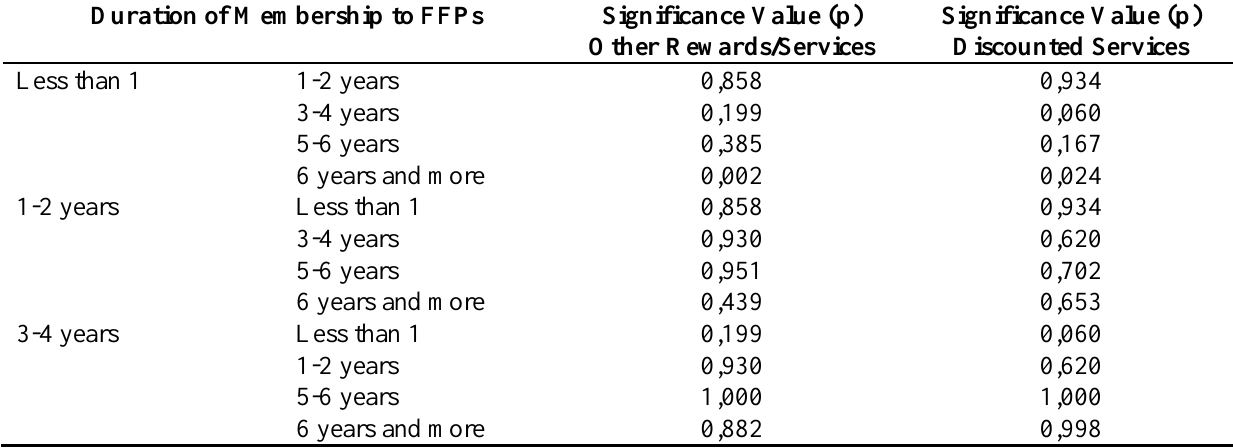
Table 15. Multiple comparison regarding duration of membership and passengers’ views on FFPs services